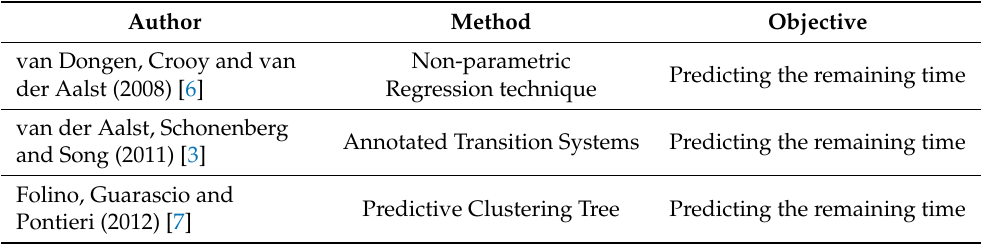
Table 1. Summary of research in